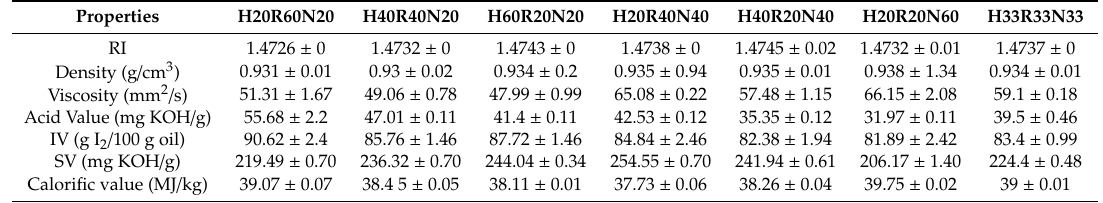
Table 3. Physicochemical properties of hone-rubber seed-neem oil